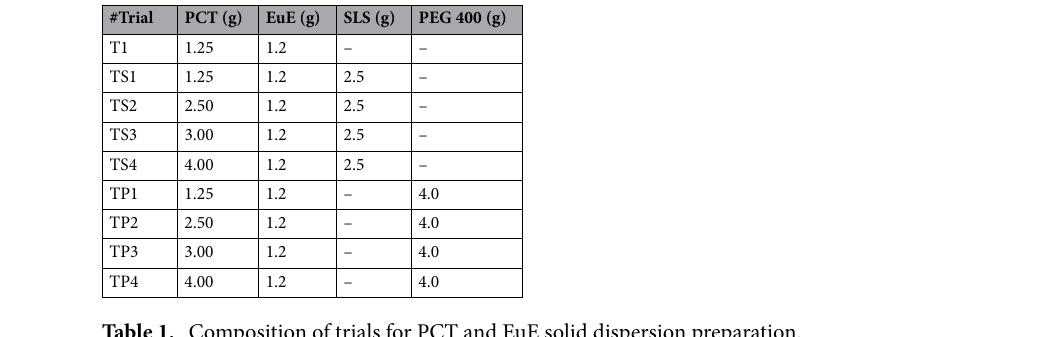
Table 1. Composition of trials for PCT and EuE solid dispersion